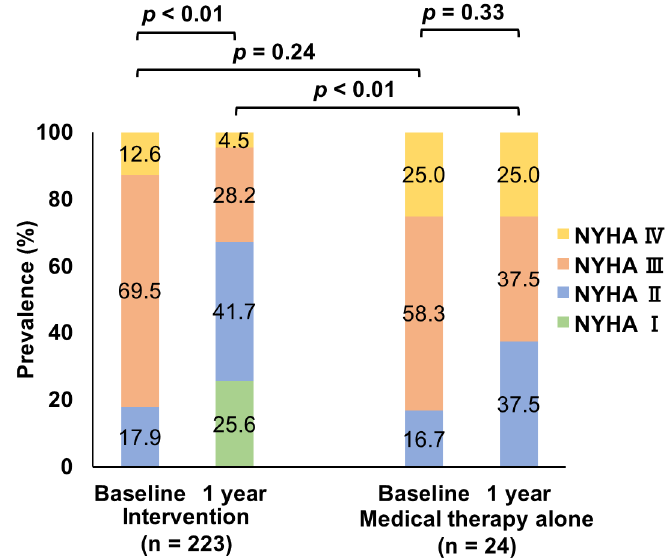
Figure 8. Changes in NYHA functional class. Mitral valve intervention was associated with an improvement in the NYHA functional class from baseline to one-year follow-up ( p < 0.01). Patients undergoing mitral valve interventions had lower NYHA functional scales compared to medical therapy alone within one-year follow-up ( p < 0.01). Abbreviations: NYHA, New York Heart Association.